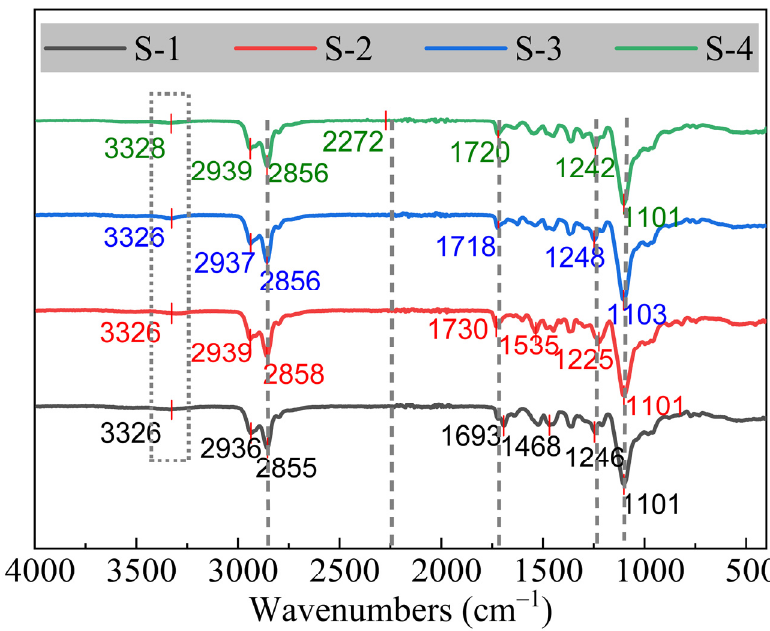
Figure 9. FTIR-ATR spectra of HTPE polyurethane binders.